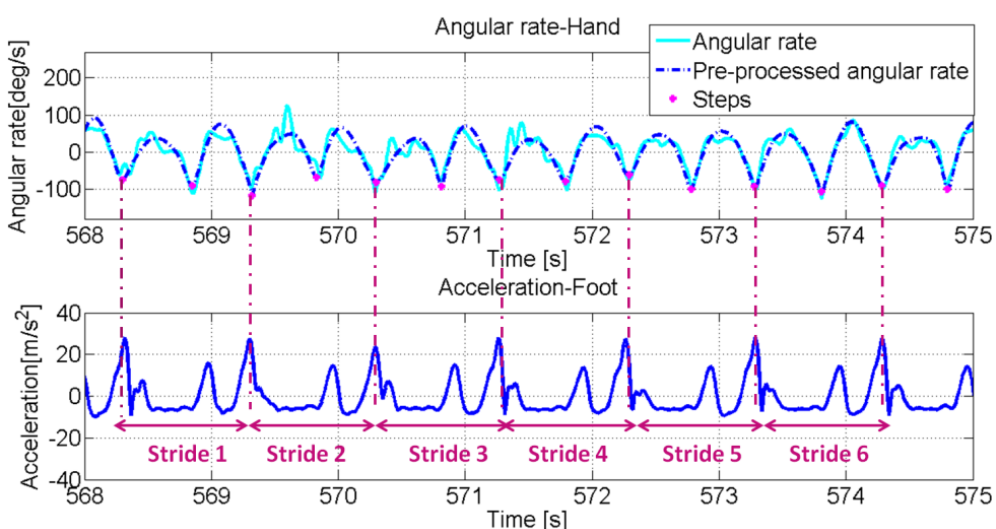
Figure 8. (Upper) Gyroscope signal (norm) recorded by the IMU in the swinging hand. The dots represent the detected step events. (Down)Accelerometer signal (norm) recorded by the IMU on the foot (the mean has been